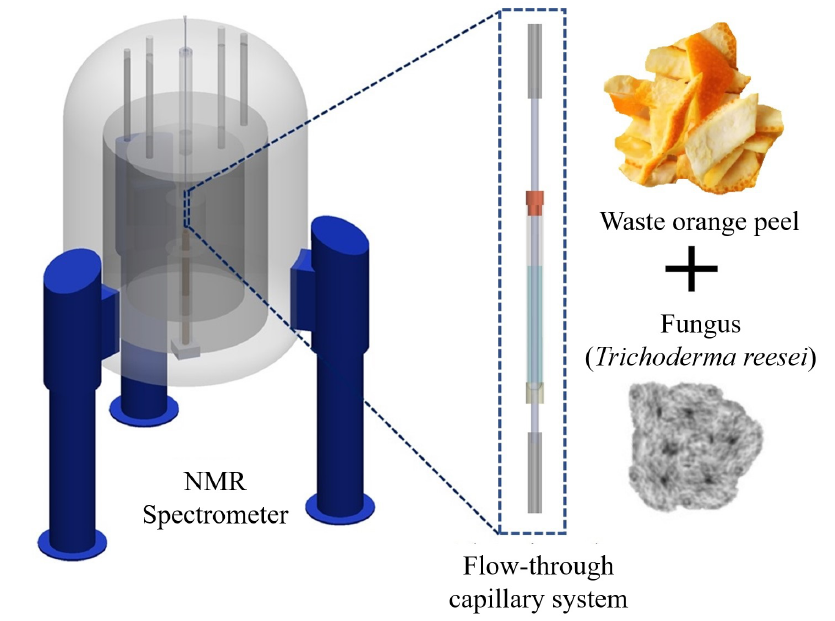
Figure 1. Conceptual diagram of the real-time Nuclear Magnetic Resonance (NMR) measurement system using a flow-through capillary arrangement. The processing of waste orange peel, with the help of ( T. reesei ) in minimal medium, was the bio-reaction to demonstrate the system